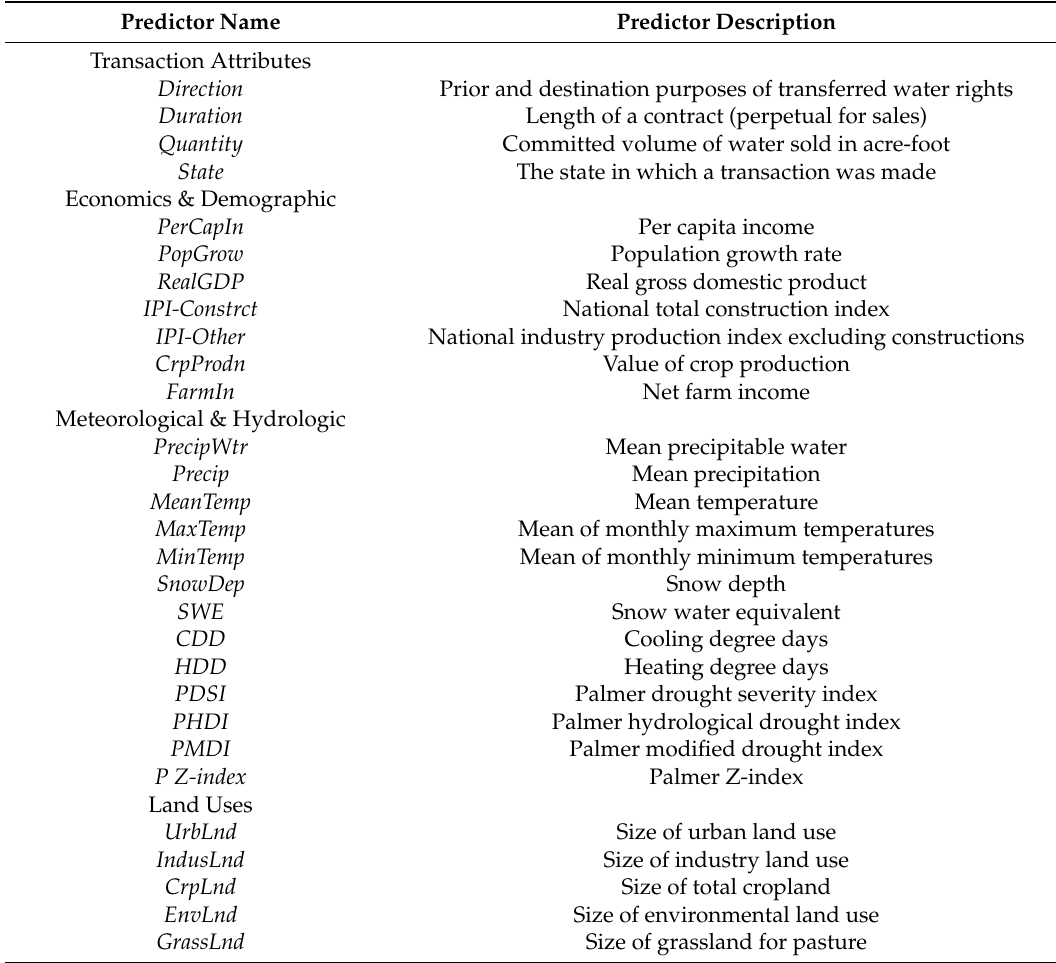
Table 1. Water rights price predictor variables and their